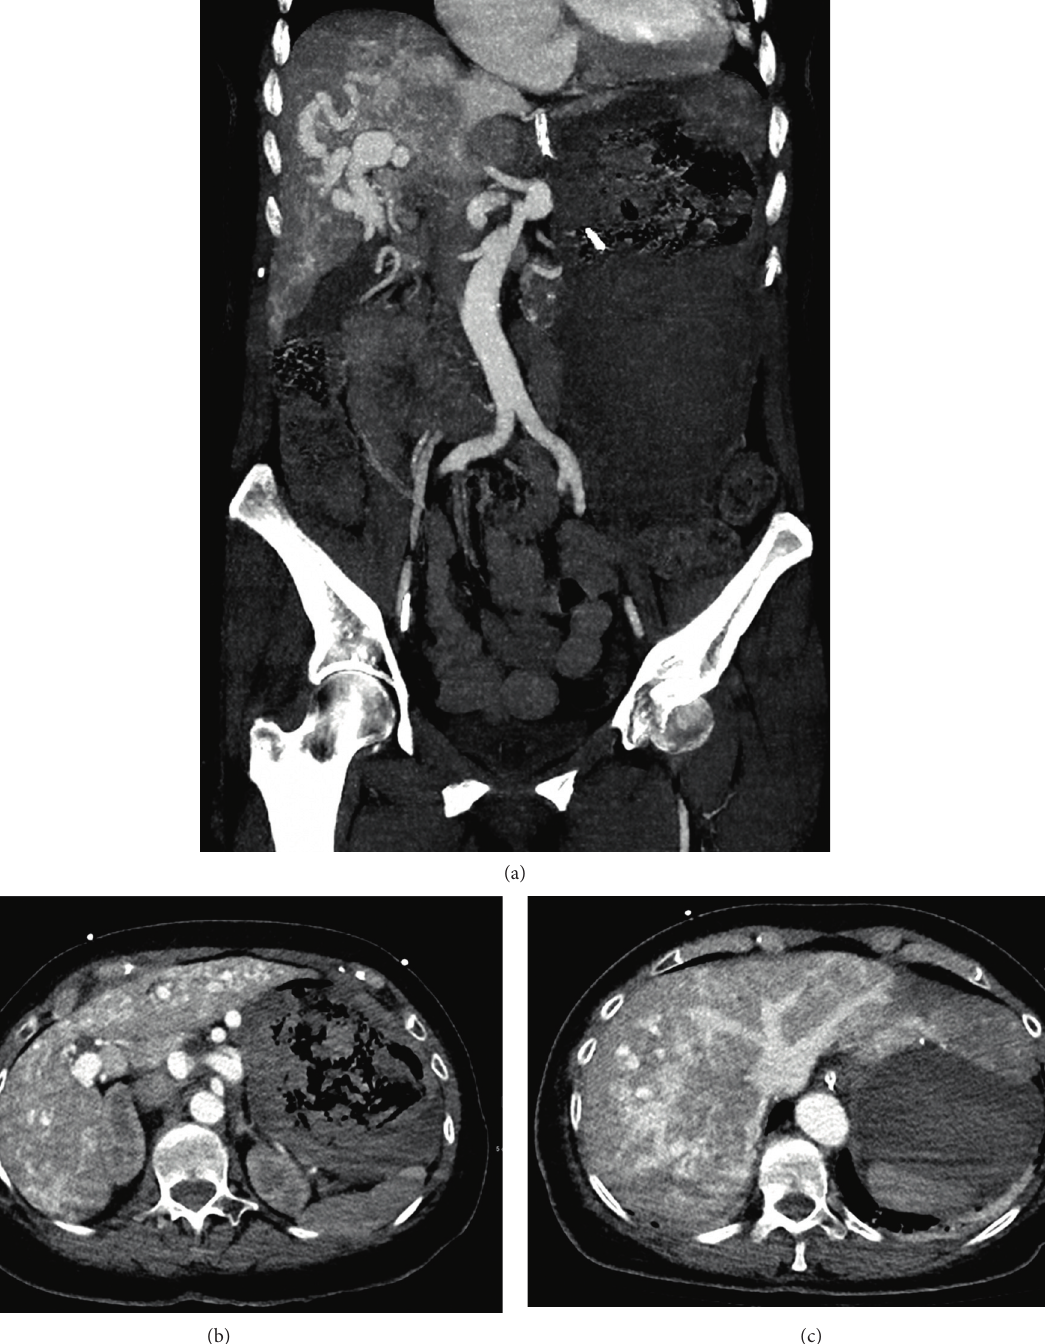
Figure 2: Coronal and axial late arterial phase abdominal CT imaging demonstrating hepatic arteriovenous shunting. (a) Coronal re- construction showing hepatic arterial enhancement, the portal venous system is not opacified with contrast. There is early contrast filling of the hepatic veins and the inferior vena cava consistent with the hepatic arteriovenous shunting. (b) Axial slice through the level of the portal vein shows no contrast opacification of the portal system. (c) Axial slice through the level of the hepatic vein shows contrast enhancement. Incidentally noted is a markedly dilated stomach filled with blood products from gastrointestinal